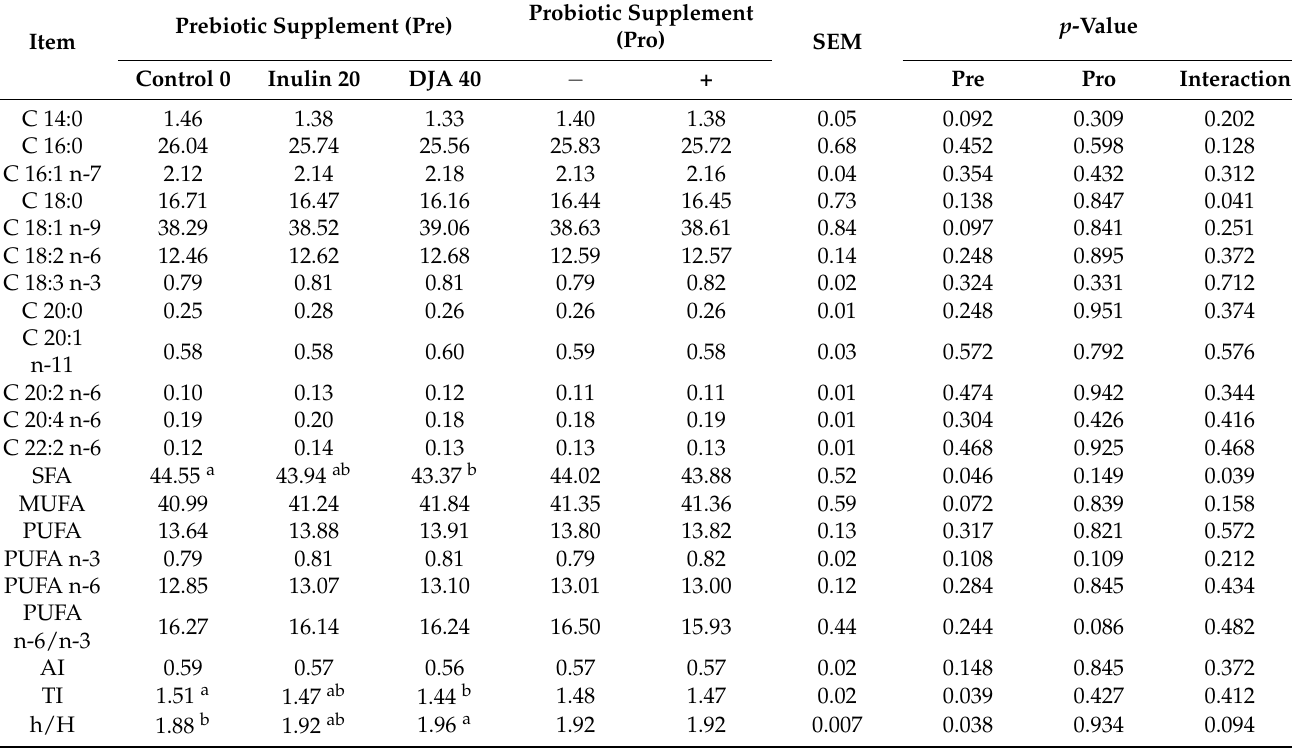
Table 9. Fatty acid composition (g per 100 g of all estimated fatty acids) in